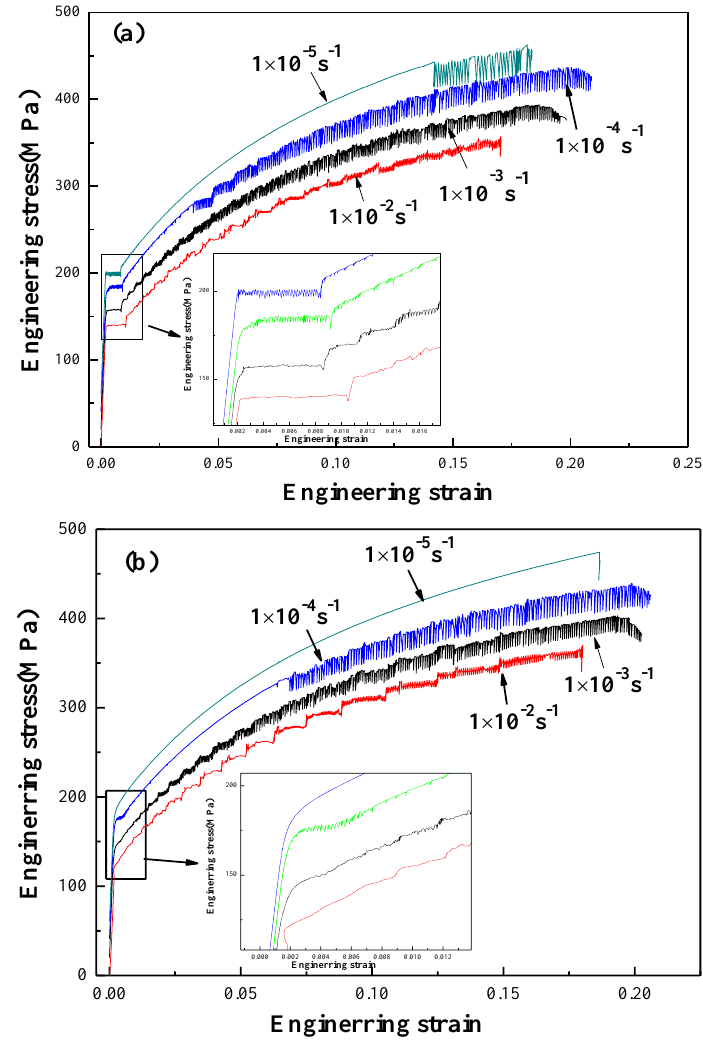
Figure 7. Engineering strain-engineering stress curves of ( a ) annealed and ( b ) quenched 5083 aluminum alloy sheets at various strain rates.